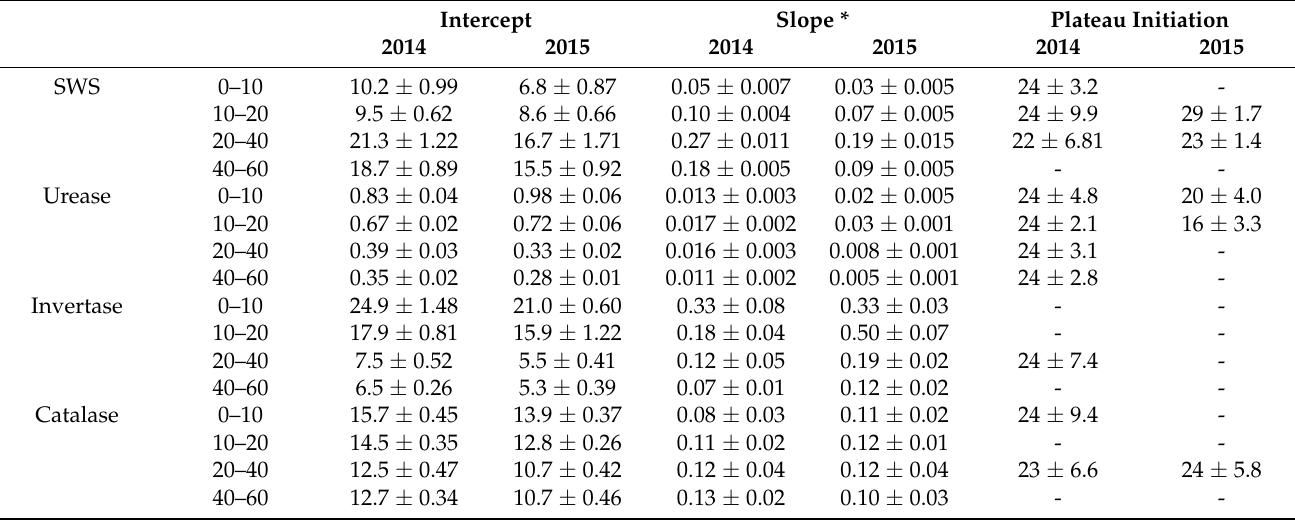
Table 4. The parameters of the 2014 and 2015 linear or piecewise linear models of soil water storage (SWS), urease, invertase, and catalase activity in different depths plotted against one-time bentonite- humic acid (BHA) application rate.